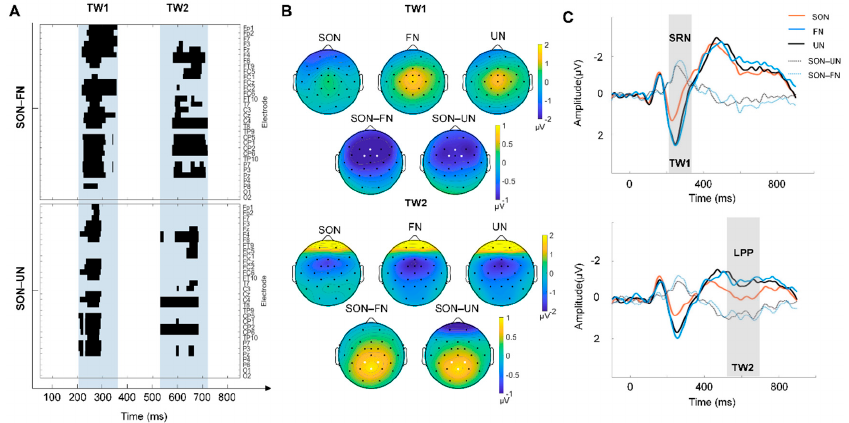
Figure 2. The result of the SON-related effect. ( A ) P-value matrices of electrodes × time points obtained from two pairwise comparisons (Top: SON–FN, Bottom: SON–UN), which were carried out with a sliding time window of 20 ms and steps of 1 ms at each electrode. The blue shaded area indicated two time windows (TW) with significant differences (cluster corrected): TW1 (210–360 ms) and TW2 (520–720 ms). ( B ) The topographic map illustrates the scalp distribution of ERP amplitudes of each condition and the difference between SON and other names (FN/UN) in TW1 (top), and TW2 (bottom). The electrodes with the greatest difference are marked with white dots: Fz, FC1, FC2 for TW1, Pz, CP1 and CP2 for TW2. ( C ) The grand averages of ERPs across Fz, FC1, and FC2 electrodes within TW1 are shown on the top. SRN stands for self-related negativity, which is the SON-evoked negative component. Grand averages of ERPs across channels Pz, CP1, and CP2 electrodes within TW2 are shown at the bottom. LPP stands for late positive potential, which is the SON-evoked positive component. The paired t-test between the two halves of trials showed decreased amplitudes of SRN in the second half trials, compared to the first half trials (SON-UN: t = 3.445, p < 0.01; Brain Sci. 2022 , 12 , x FOR PEER REVIEW SON-FN: t = 2.334, p < 0.05) (Figure 3A). No significant difference of amplitude was found in LPP between the two halves of trials (Figure 3B).